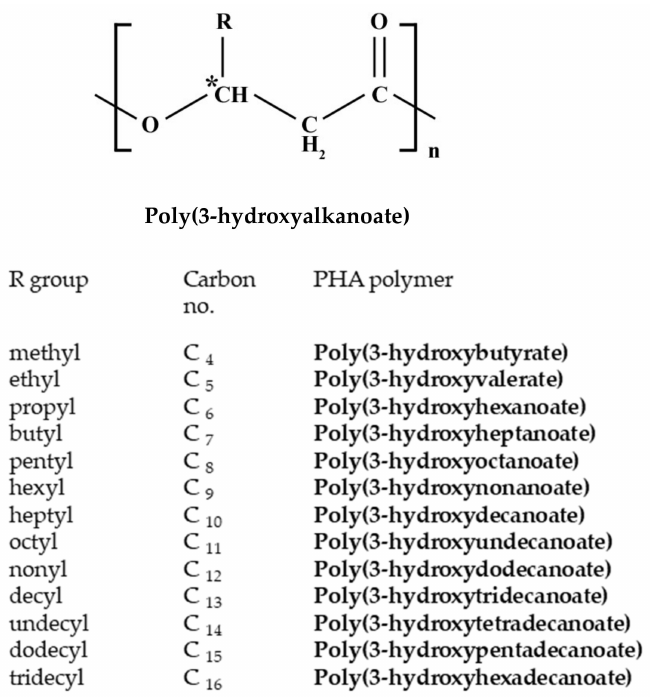
Figure 7. General structure of various PHAs, reproduced from